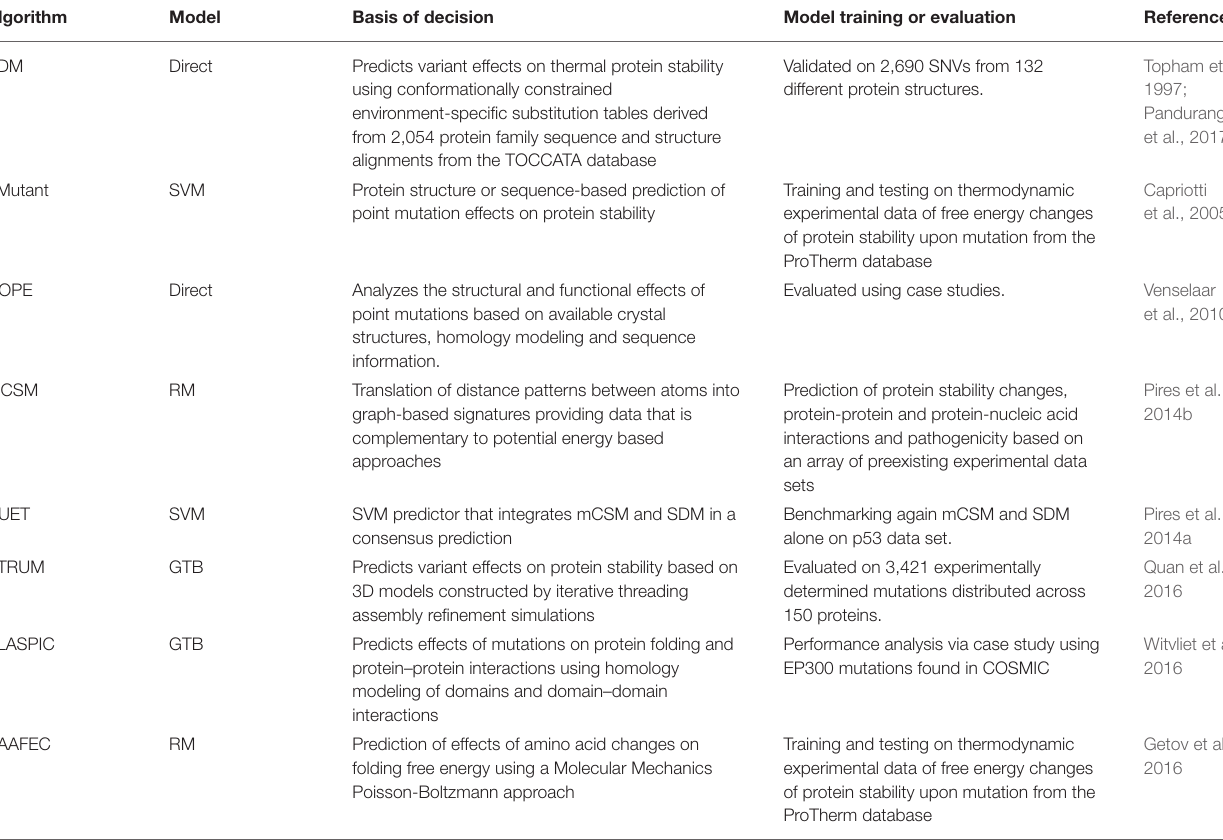
TABLE 2 | Methods to predict the functional effect of missense variants based primarily on structural